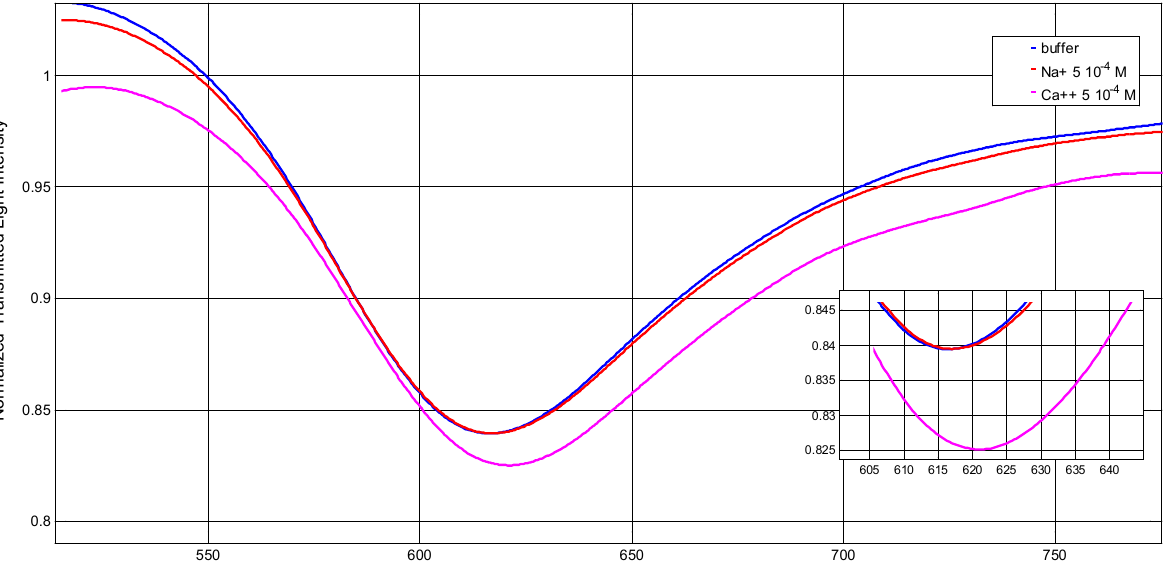
("buffer" solution) is 3